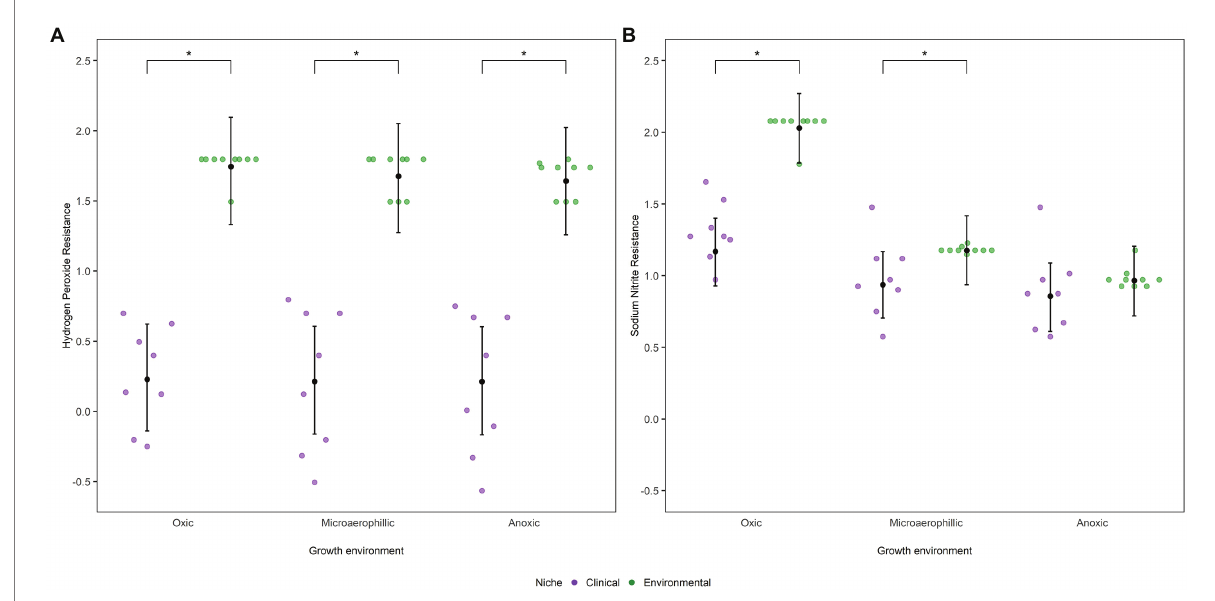
FIGURE 2 Dot plots represent mean MIC values (log 10 transformed) of P. aeruginosa strains as a function of niche and environment for oxidative stressors. (A) Hydrogen peroxide and (B) Sodium nitrite. The posterior mean and 95% CIs are indicated by the black dot and whiskers, respectively, as calculated from the phylogenetic mixed model as determined by MCMCglmm. Statistically significant differences, α < 0.05, between niches as estimated by emmeans are depicted by